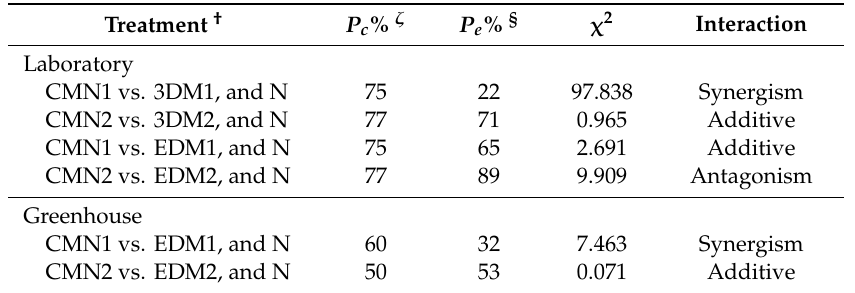
and P. locustae at high concentration of M. brunneum . N = 3 days’ exposure to P. locustae . C = Untreated control. χ 2 = Chi square. ζ Pc = observed percentage mortality from CMN1 / CMN2 vs. § Pe = expected percentage mortality